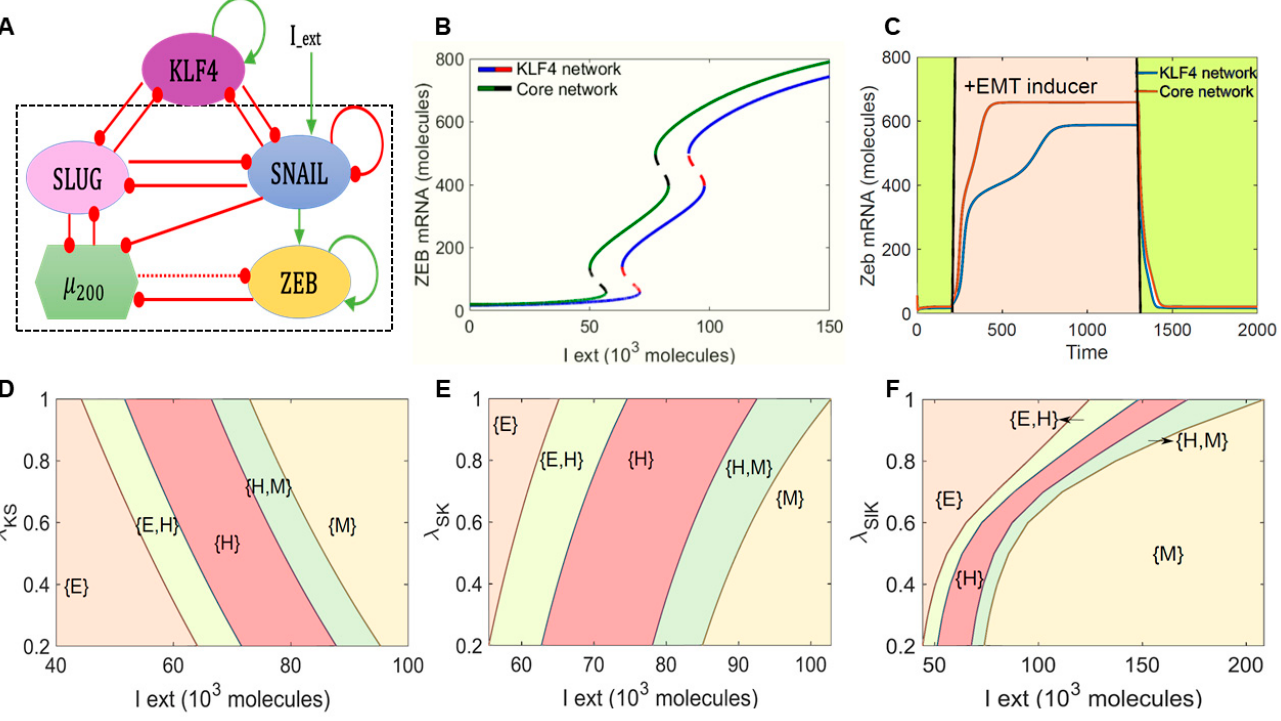
Figure 1. KLF4 inhibits EMT. ( A ) Schematic representation of KLF4 coupled to an EMT regulatory network consisting of miR-200, ZEB1, SNAIL, and SLUG. Green arrows denote activation, and red bars indicate inhibition. Solid arrows represent transcriptional regulation; a dotted line represents microRNA-mediated regulation. The circuit shown within the dotted rectangle is the control case (i.e., core EMT network without KLF4). ( B ) Bifurcation diagrams indicating ZEB1/2 mRNA levels for increasing the external signal (I) levels for the coupled EMT–KLF4 circuit (solid blue and dotted red curve) and the core EMT circuit (solid green and dotted black curve). ( C ) Temporal dynamics of the ZEB1/2 mRNA levels in a cell starting in an epithelial phenotype when exposed to a high level of an external EMT signal (I_ext = 100,000 molecules) (pink-shaded region) for the circuits shown in ( A )). ( D – F ) Phase diagrams for the KLF4–EMT network driven by an external signal (I_ext) for ( D ) varying strengths of repression on SNAIL by KLF4, ( E ) for varying strengths of repression on KLF4 by SNAIL, and ( F ) for varying strengths of repression on SLUG by KLF4.